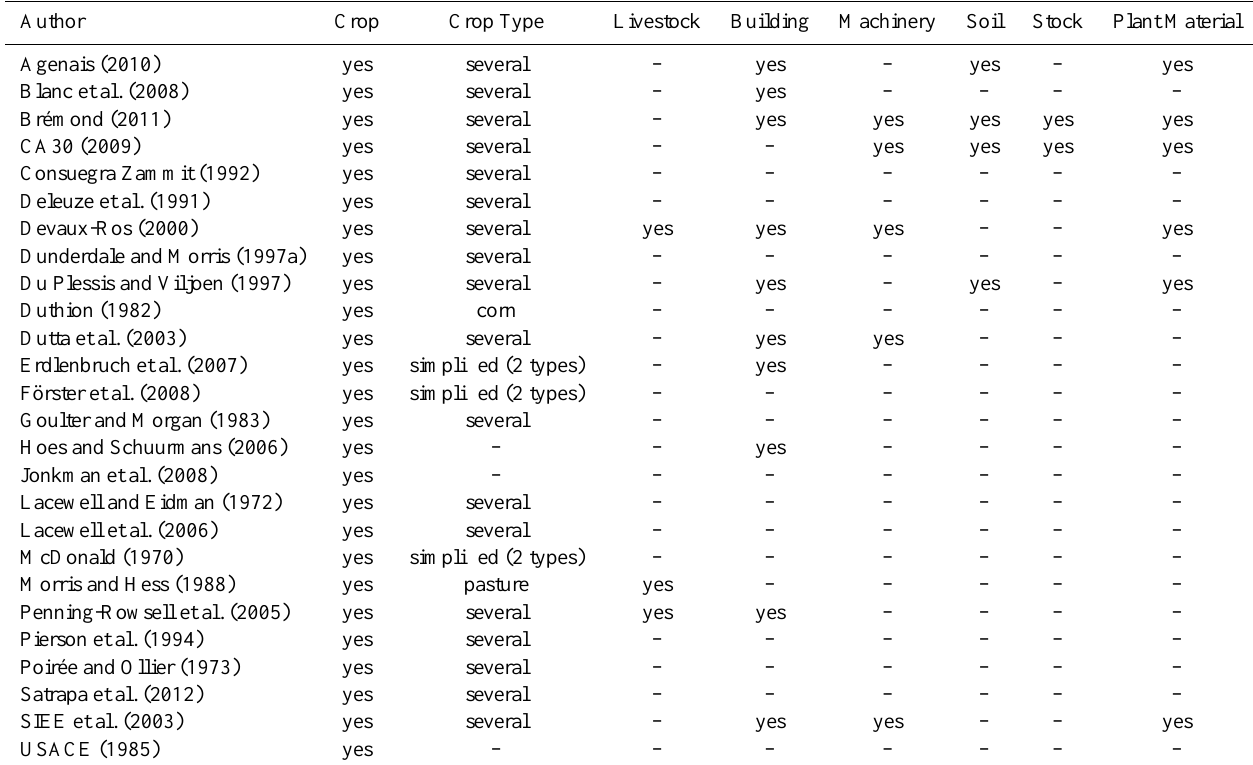
Table 3. Farm components taken into account for the evaluation of direct damage in the studies